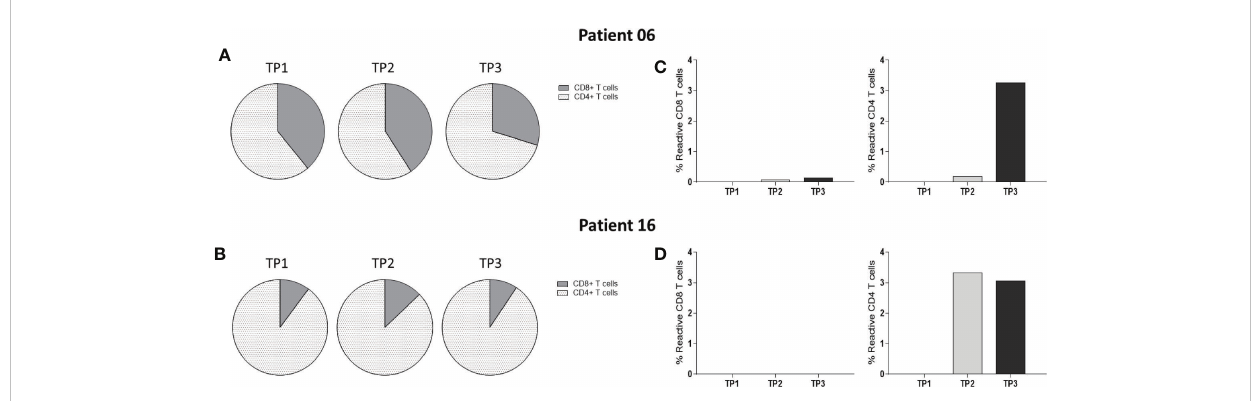
FIGURE 5 Multicytokines Intracellular staining assay of PBMCs from two patients at three TPs: Bcl-XL_42-speci fi c reactivity of PBMCs isolated from two patients enrolled. Reactive cells were simultaneously positive to two of the four reactivity markers CD107a, TNF a , IFN- g , and CD137. (A, B) Fractions of CD4+ and CD8+ T cells within PBMCs populations at each TP for the two patients. (C) Reactive CD4+ and CD8+ T cells were observed in a meager percentage in patient 6. (D) Reactive CD4+ T cells were observed in patient 16. Data were analyzed using FlowJo software and GraphPad Prism